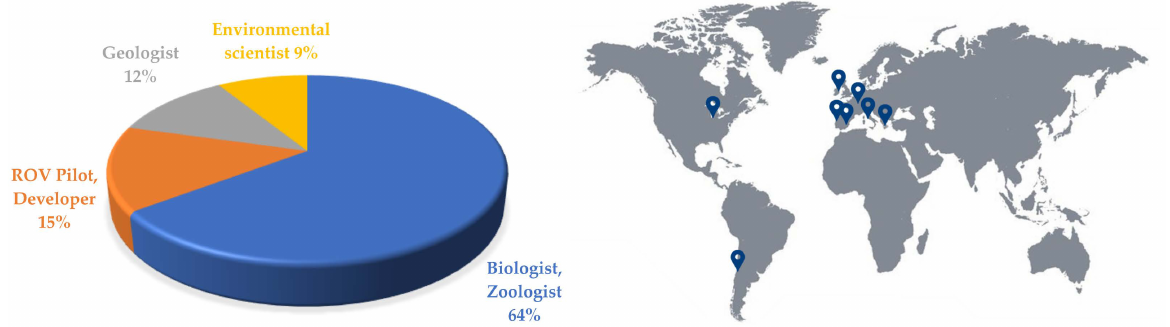
Figure 1. ( a ) Role of the researchers that participated in Step 2 questionnaires and